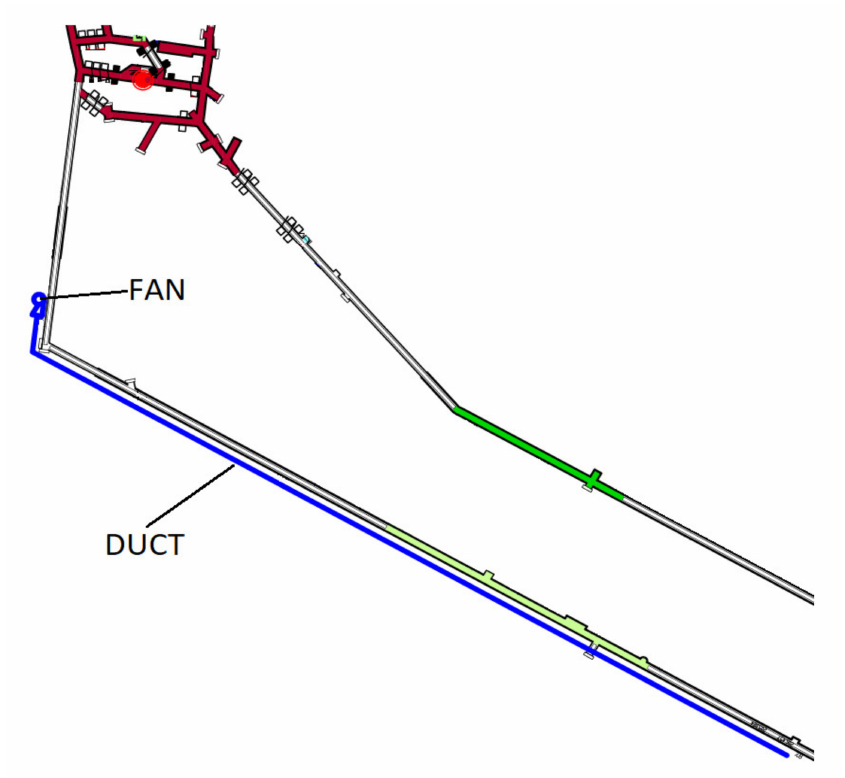
Figure 9. An overview drawing of the test stand at Premogovnik Velenje (coalmine). Initially, the connectors were installed at 20 m intervals. Due to the long communi- cation range between the modules, which was verified during the first day of testing, the location of the section connectors was changed prior to the measurement tests so that